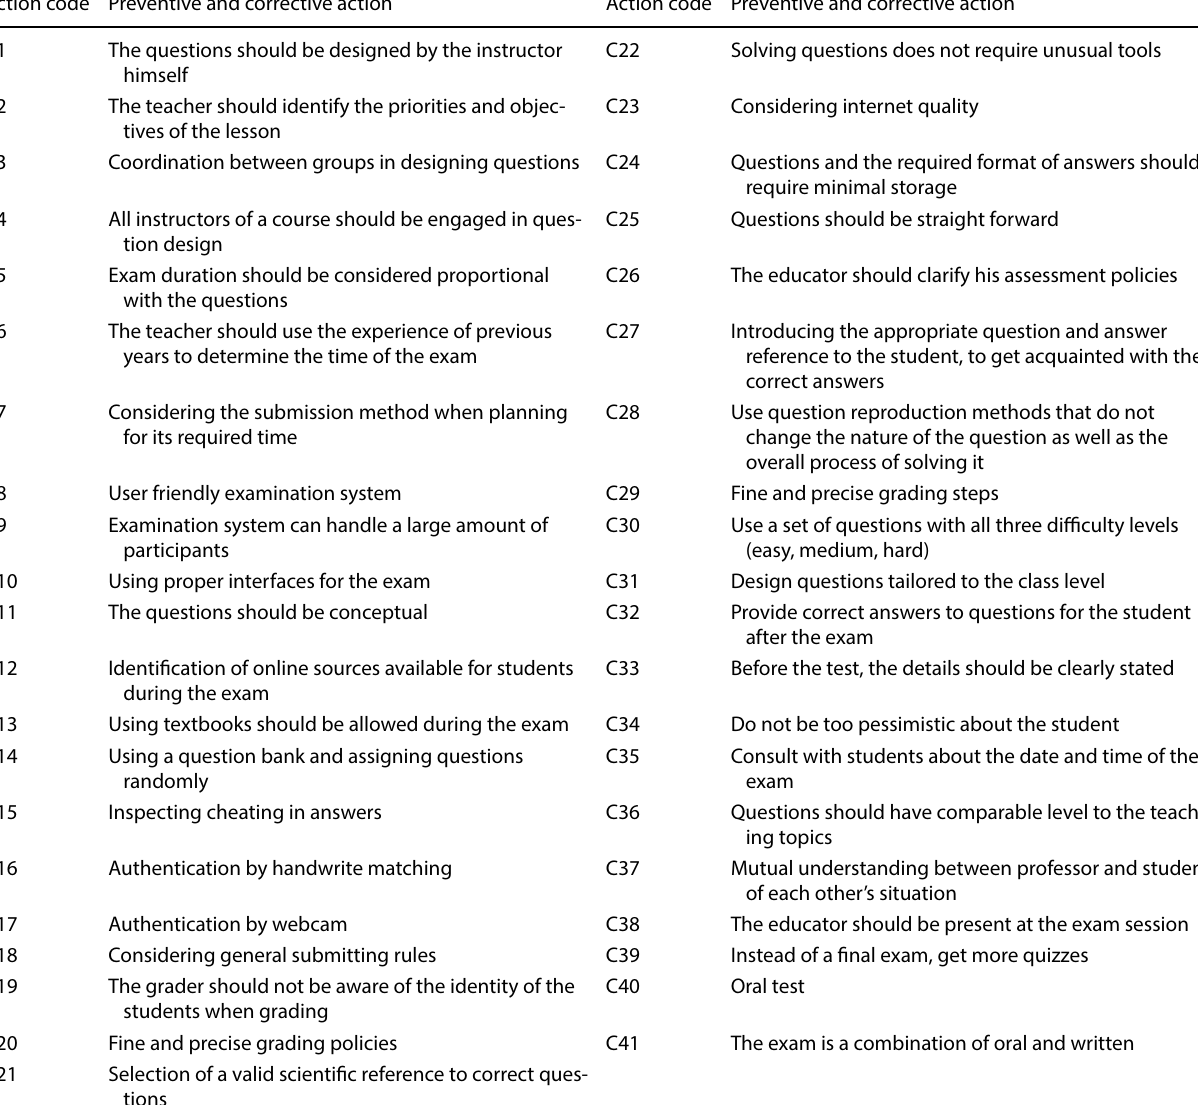
Table 10 Preventive and corrective actions Action code Preventive and corrective action